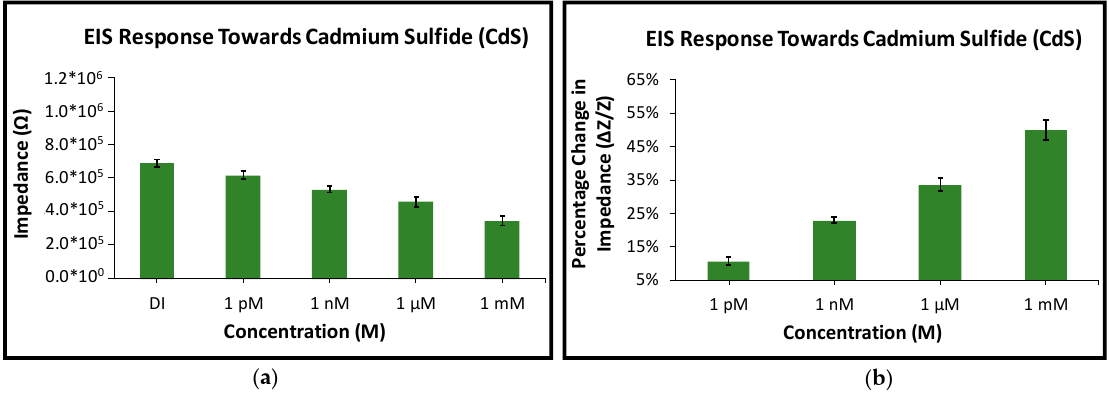
Figure 3. ( a ) EIS response of the printed sensor towards varying concentrations of CdS; ( b ) Percentage change in impedance of the printed sensor for varying concentrations of